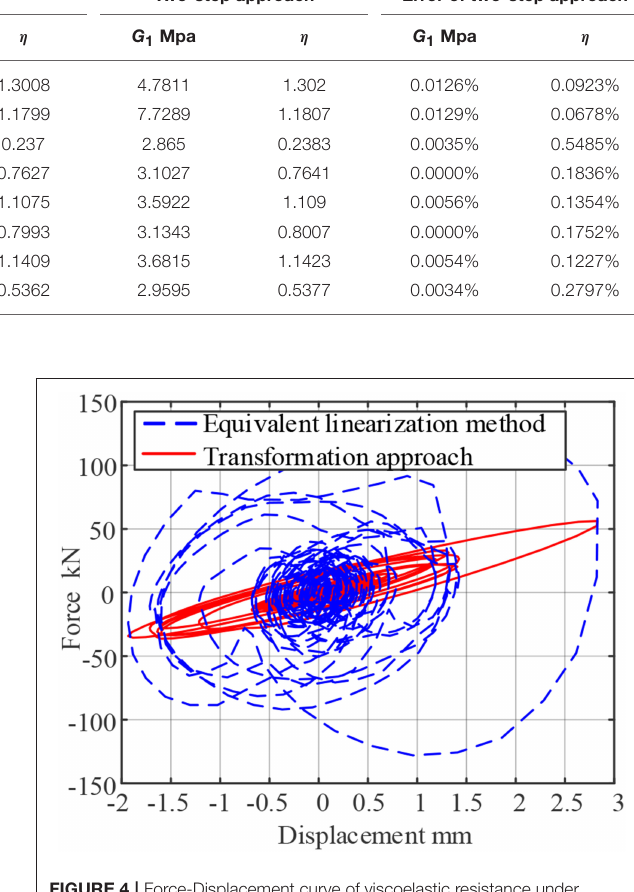
quantify the exact error that the equivalent linearization method brings to the system.